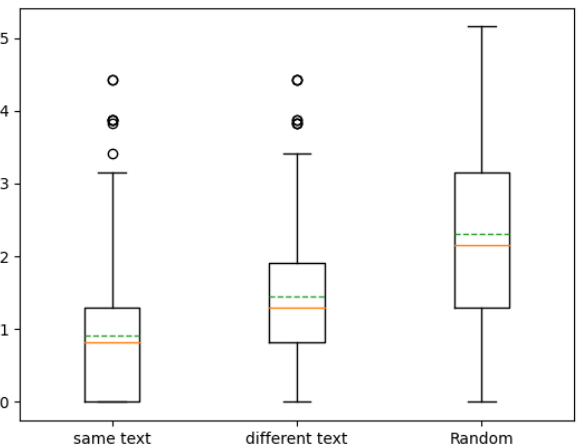
Figure 6. Boxplots of the distances between participant choices and true locations of the reference (lower is better). From left to right: (1) results of the first variant of the experiment for which the text synthesized is the same for the reference and the latent space, (2) results of the second variant for which the text synthesized is different for the reference and the latent space, and (3) a random